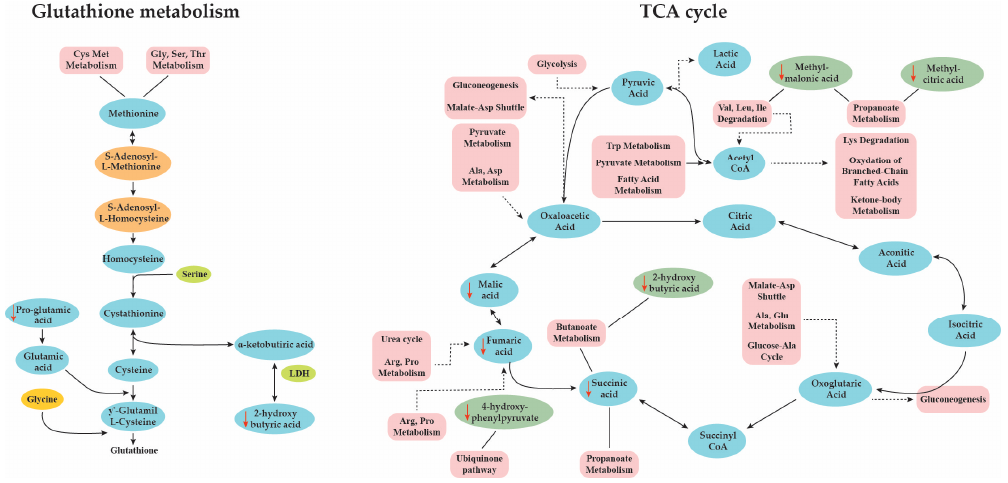
Figure 7. Summary of significantly altered organic acids in ADs and involved